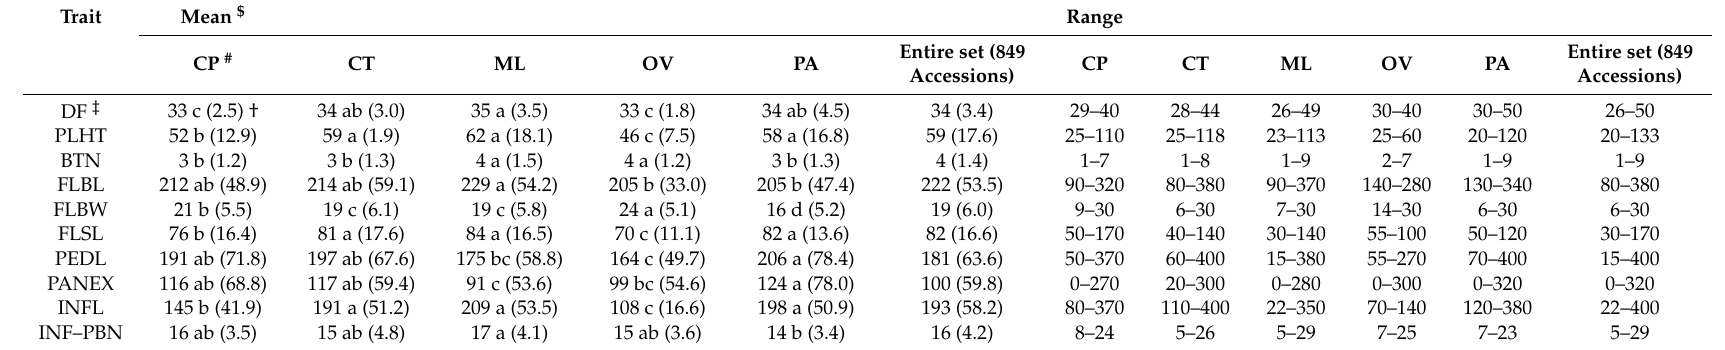
Table 4. Mean and range of proso millet germplasm conserved at the ICRISAT genebank for agronomic